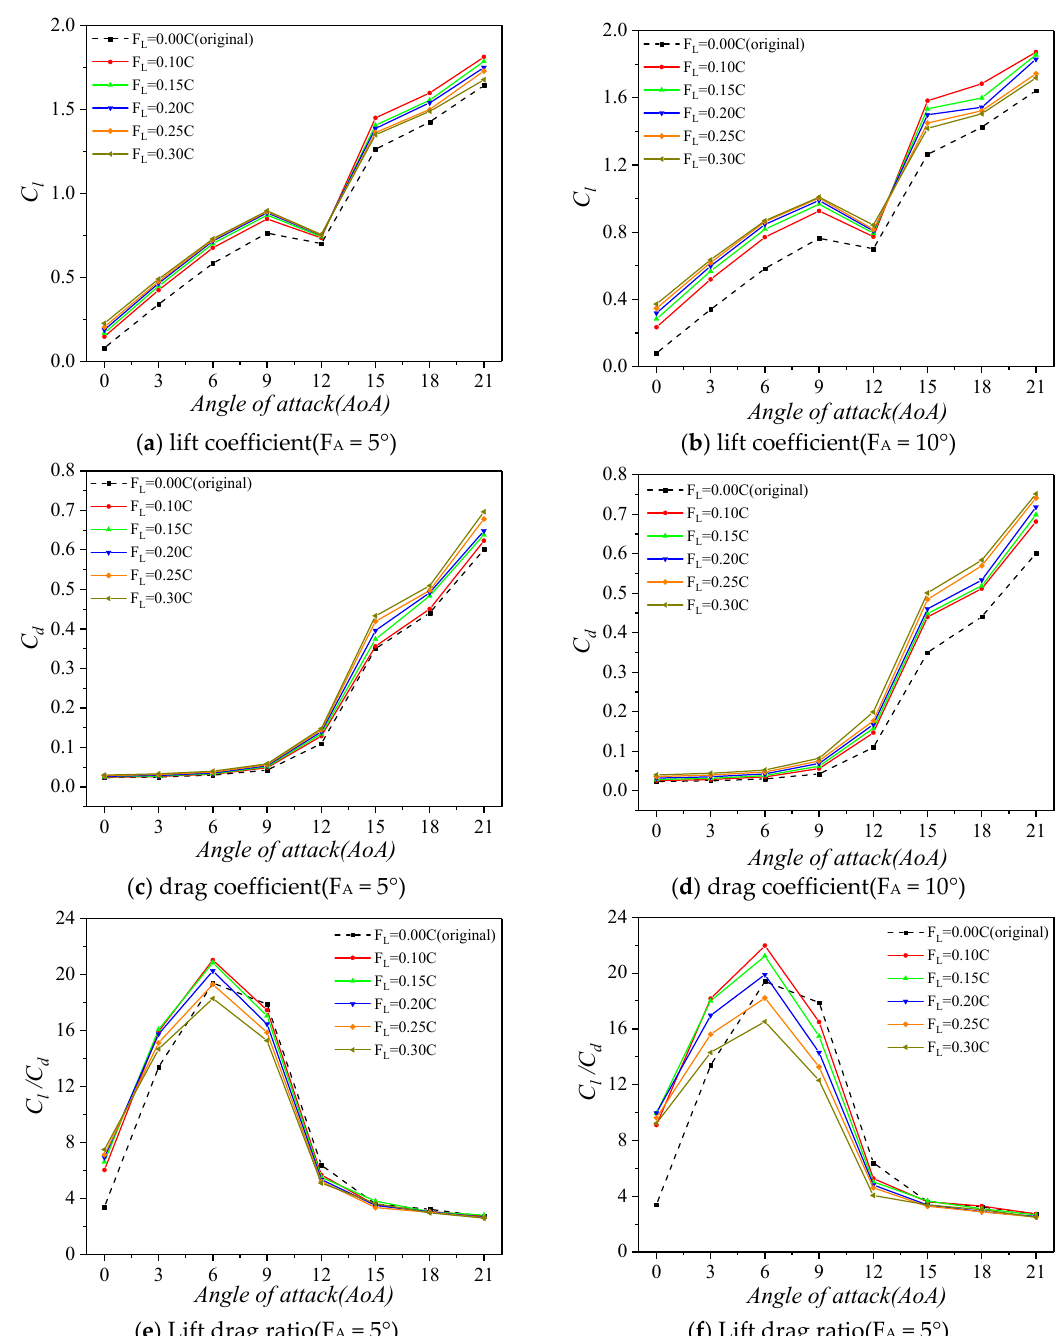
Figure 7. Influence of F L on hydrodynamic performance of hydrofoil (Re = 3.5 × 10 5